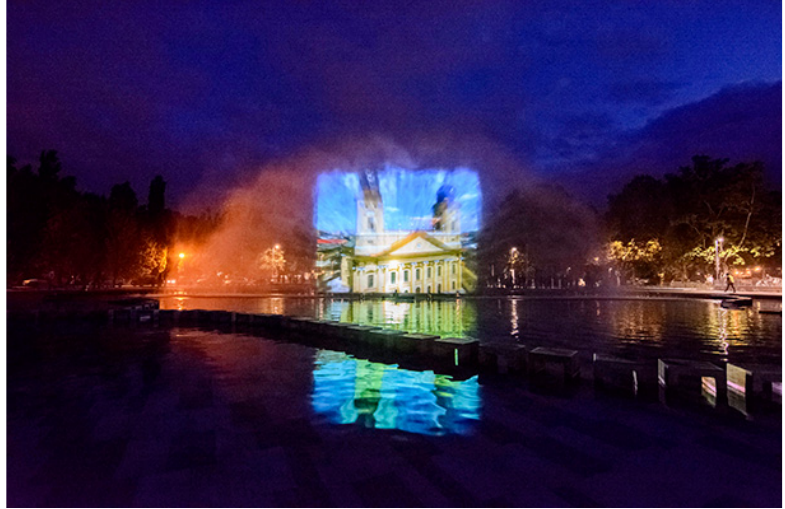
Figure 11. Fog theatre in the southern part of Great Forest Park. Source: own collection.